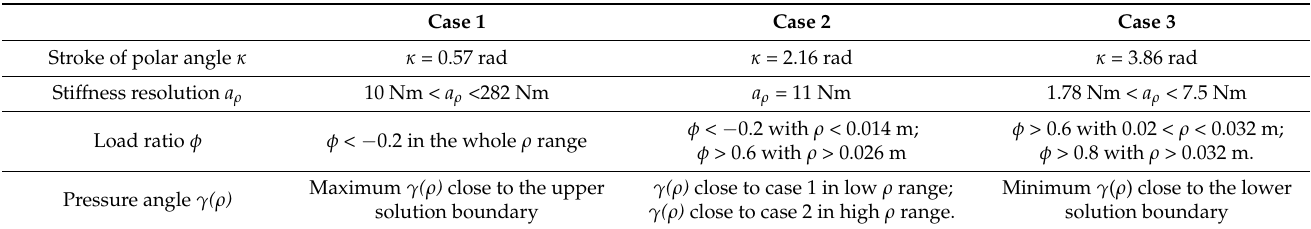
Table 1. The difference and relationship among the three cam reconfiguration